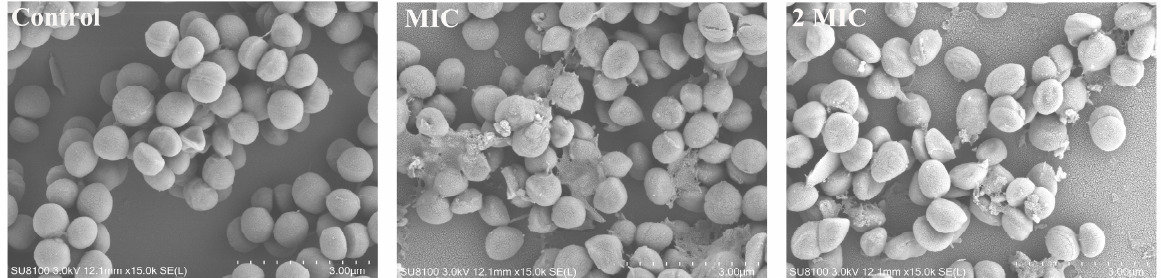
Figure 4. Effect of juglone on the cell morphology of S. aureus observed by field emission scanning electron microscopy. The scale bar is 3 µ m.